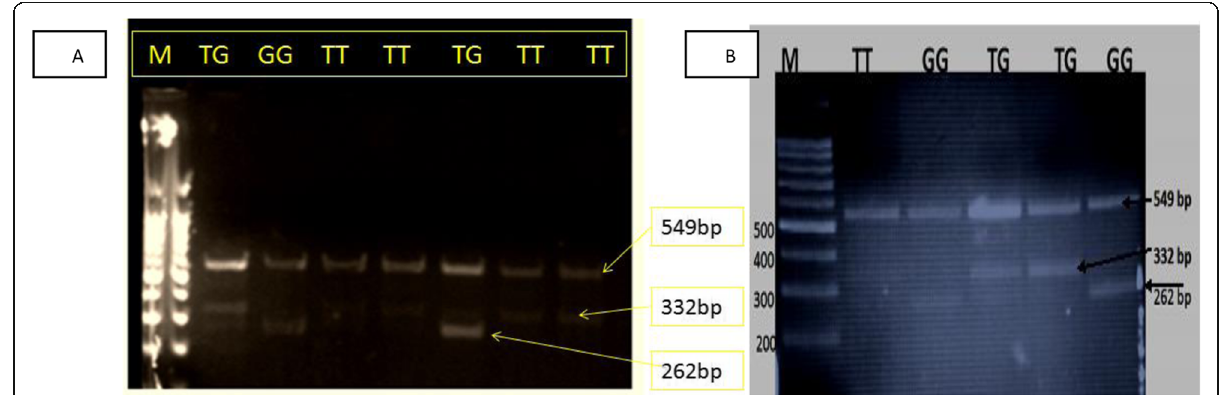
Fig. 4 Agarose gel electrophoresis for the detection of RARRES2 rs17173608 gene polymorphism . a Left. b right. M; 1000 bp DNA marker. Product sizes were 262 bp for G allele, 332 bp for T allele, and 549 bp for two common primers. Genotyping labeled above each lane